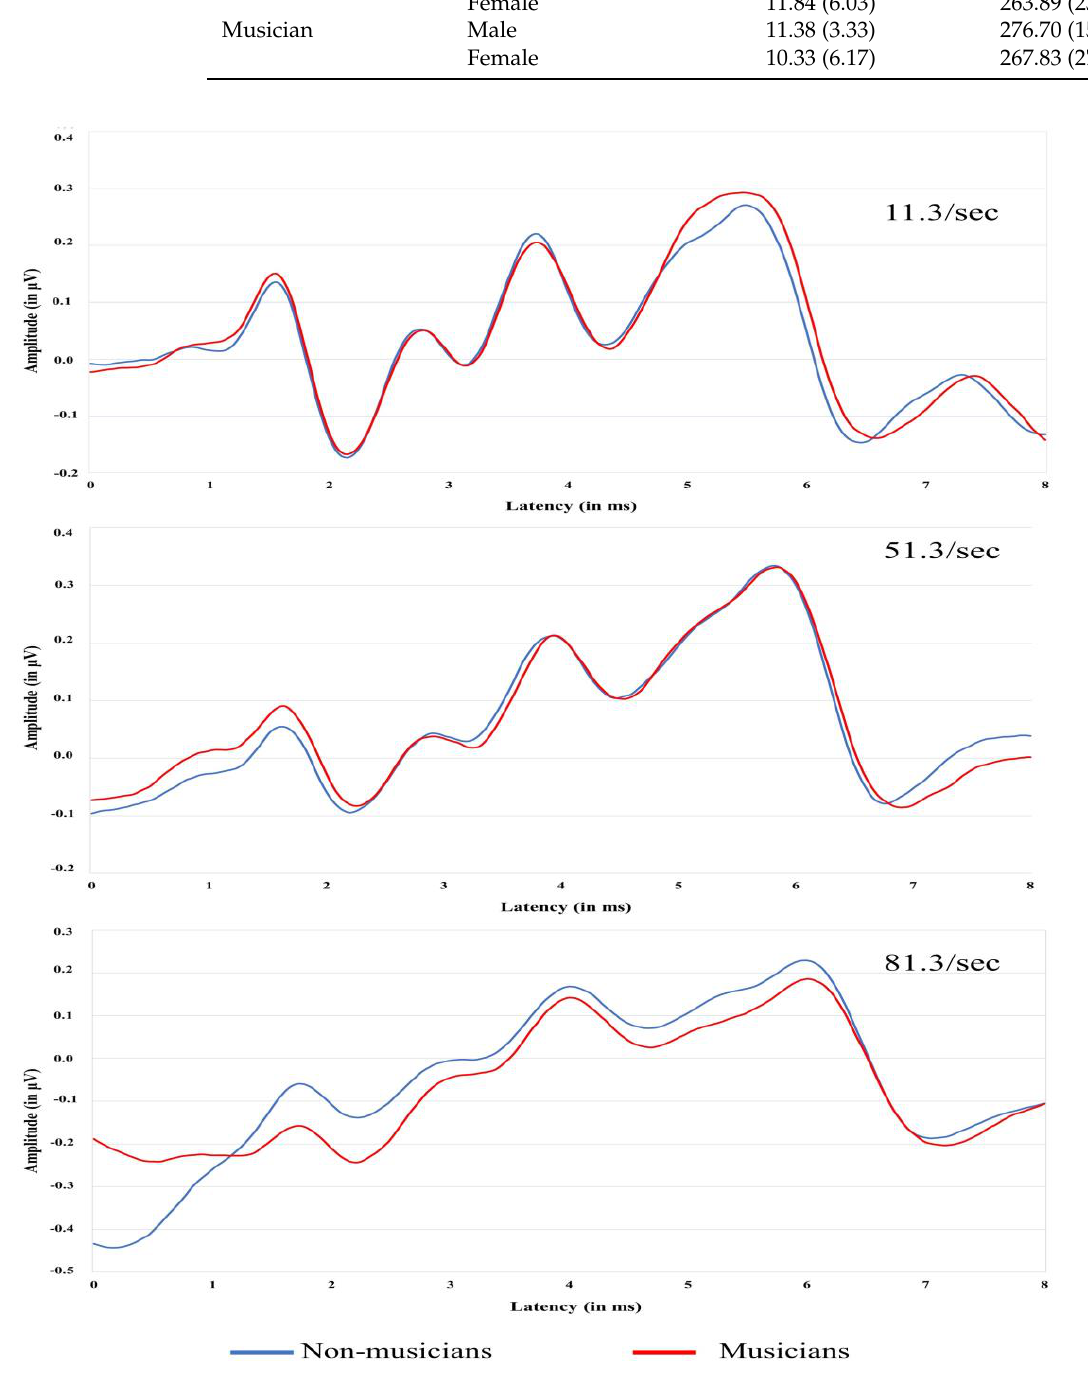
Figure 3. Grand average ABR waveforms of two groups collected at three stimulus repetition rates 11.3, 51.3, and 81.3/s. The X -axis corresponds to latency, and the Y -axis corresponds to ABR wave amplitude measured in µV.